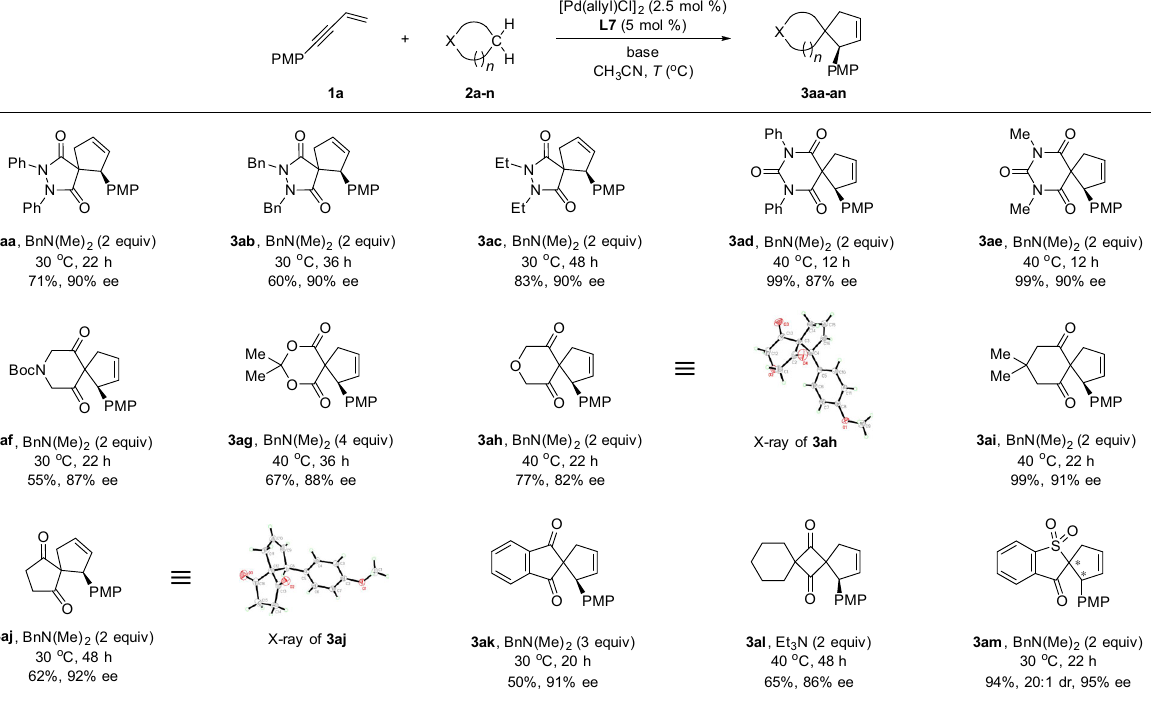
Fig. 4 Pd/WingPhos catalyzed enyne cycloaddition with various cyclic pronucleophiles. The reactions were carried out on a 0.1-mmol scale. Isolated yields are